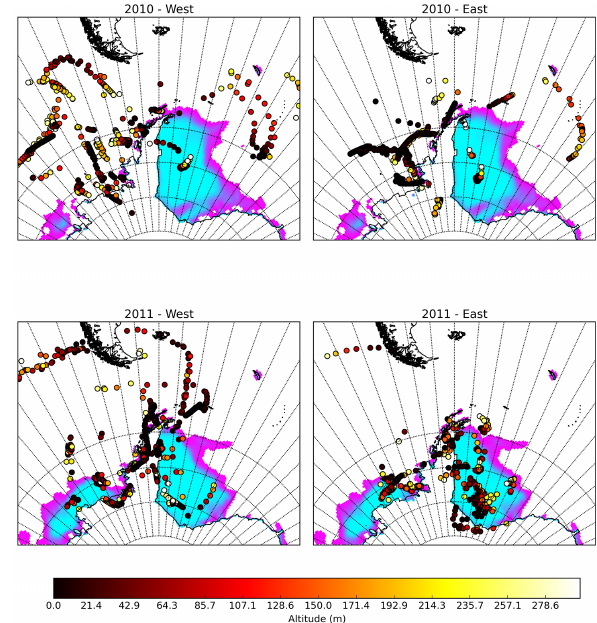
Figure 12. Location and altitudes (colour-coded, in m) of low- altitude ( ≤ 300m above ground) air masses 48h prior to reaching a flight track (from either of the 55 flights used in Fig. 11) west (left column) or east (right column) of the peninsula. Over-plotted is the monthly averaged sea ice fractional coverage as obtained from Nimbus-7 SMMR daily data at 25km resolution (see text for refer- ence) (lightest blue is > 90%, darkest blue is 50%, dark magenta is 25%, and lightest magenta is below 1%). West refers to 74–67 ◦ W, and east refers to 65–60 ◦